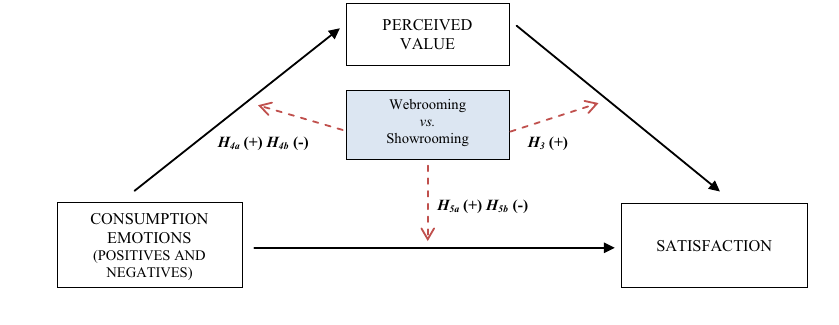
Universe Data collection Structured survey Scope of study Northern region of Spain Sample size and random routes Sample